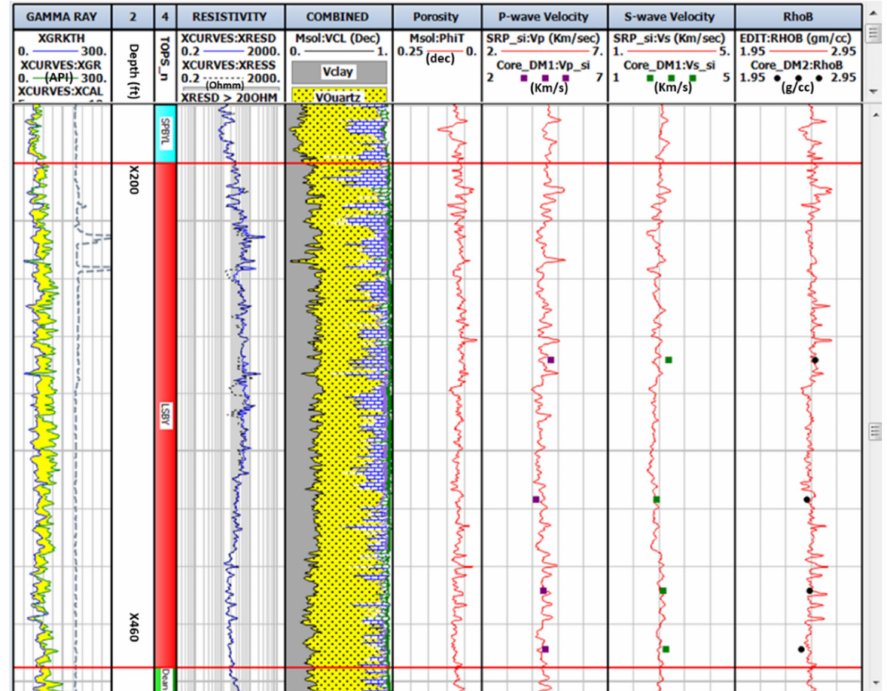
Figure 16. Log plot of the lower Spraberry shale formation. The GAMMA RAY track contains Gamma-ray (green curve) and spectral gamma-ray (blue curve). The RESISTIVITY track contains resistivity log. The COMBINED track contains formation lithology fractional volumes determined by volumetric log analyses. The porosity track contains total porosity. The P-wave velocity track contains sonic P-wave velocity (red curve) and ultrasonic P-wave velocity (purple square discrete data points). The S-wave velocity track contains sonic S-wave velocity (red curve) and ultrasonic S-wave velocity (green discrete data points). The RhoB track contains log measured bulk density (red curve) and core measured bulk density (black discrete data). Depths in the depth track are only to indicate depth scale; actual depths are not available for